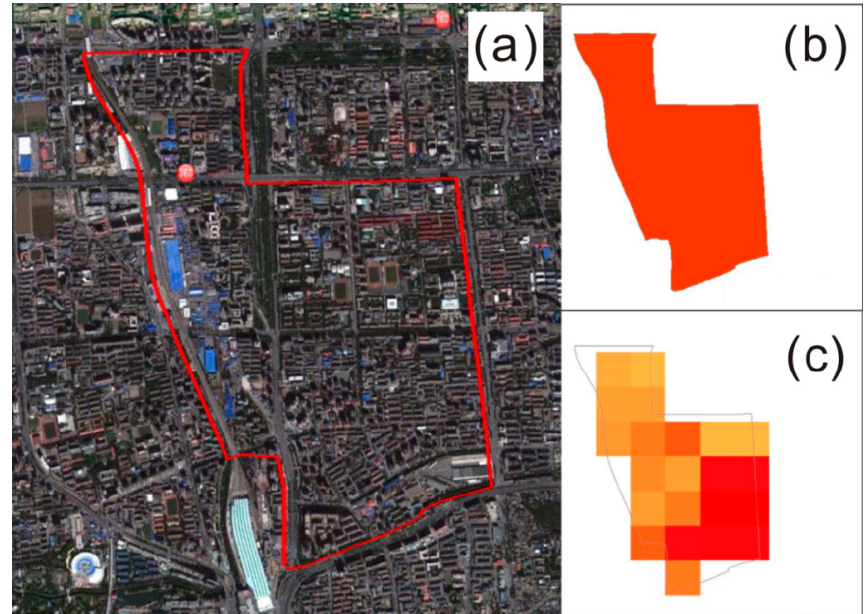
Figure 12. Comparison of the Google Earth image ( a ), census population data ( b ) and remotely-sensed population ( c ) in North Taipingzhuang subdistrict. The red line in ( a ) is the boundary of the subdistrict. Figures b and c use the same legend as Figure 9.